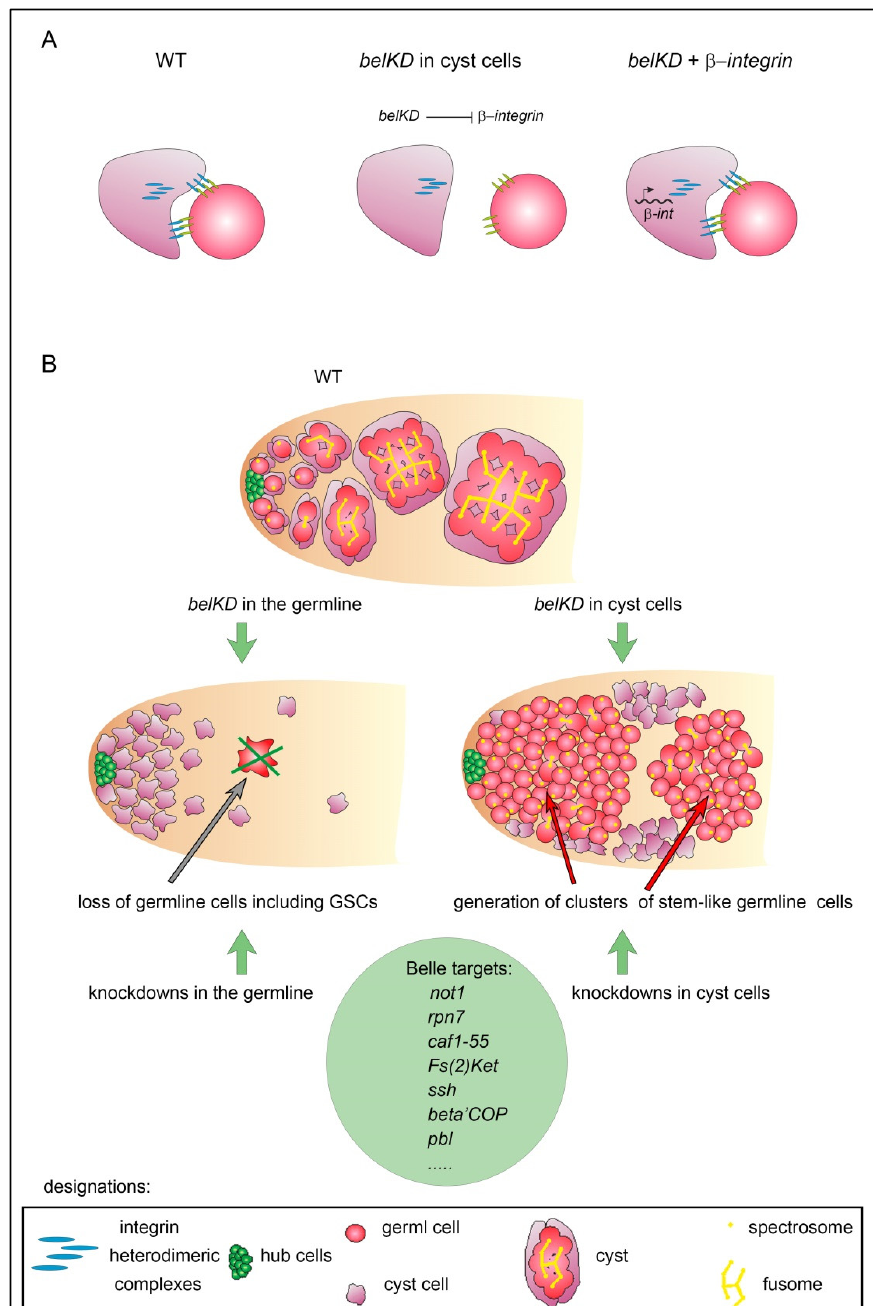
Figure 6. Belle functions in cyst cells ensuring spermatogenesis maintenance. ( A ) A model of how Belle regulates cyst formation and prevents tumorigenesis of early germ cells in the Drosophila testis via indirect control of integrin adhesion complexes, ensuring localization or stability of integrin complexes. Transgenic overexpression of β -integrin in cyst cells provided restoration of premeiotic stages of spermatogenesis in the RNAi belKD testes. ( B ) Dual role of Belle in spermatogenesis. Representation of the different defects of early stages of spermatogenesis caused by RNAi belKDs in the germline and somatic cyst cells. Whereas belKD in the germline leads to total germ cell loss with the maintenance of somatic cyst cells [25], belKD in cyst cells non-autonomously induces the generation of tumor-like clusters of early germ cells. Below: knockdowns of selected Belle targets lead to the same developmental disorders in the testes. Designations for A and B are presented in the box at the